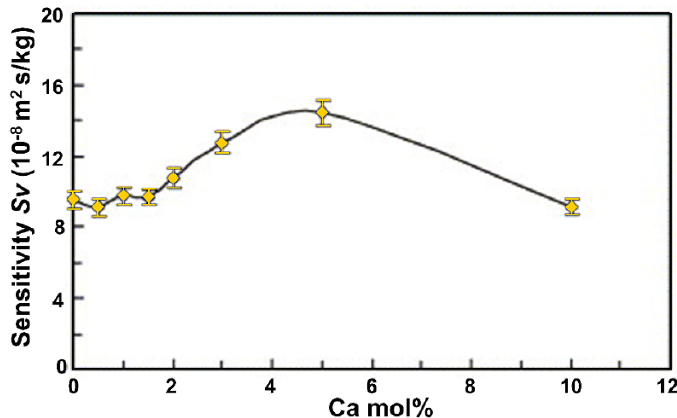
Figure 6. Increased sensitivity as a function of Ca dopant concentration. Obtained from reference [83].